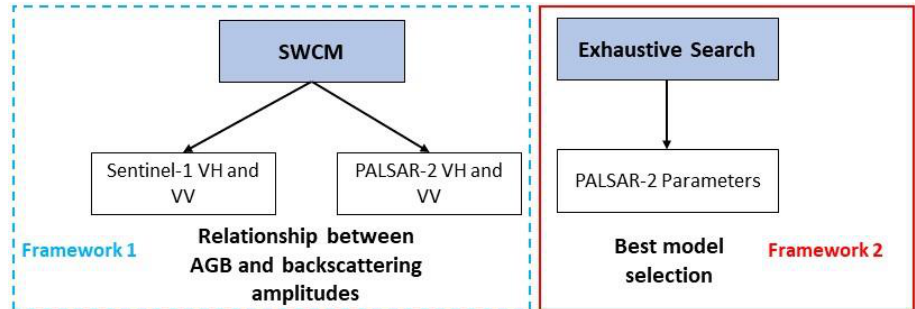
Figure 2. Two modeling frameworks. Framework 1 (cyan dash box) is to investigate the relationship between AGB and backscattering amplitudes using the SWCM for Sentinel-1 (S1) and PALSAR-2 (P2), and Framework 2 (red solid box) is to select the best model using the multiple linear regression.